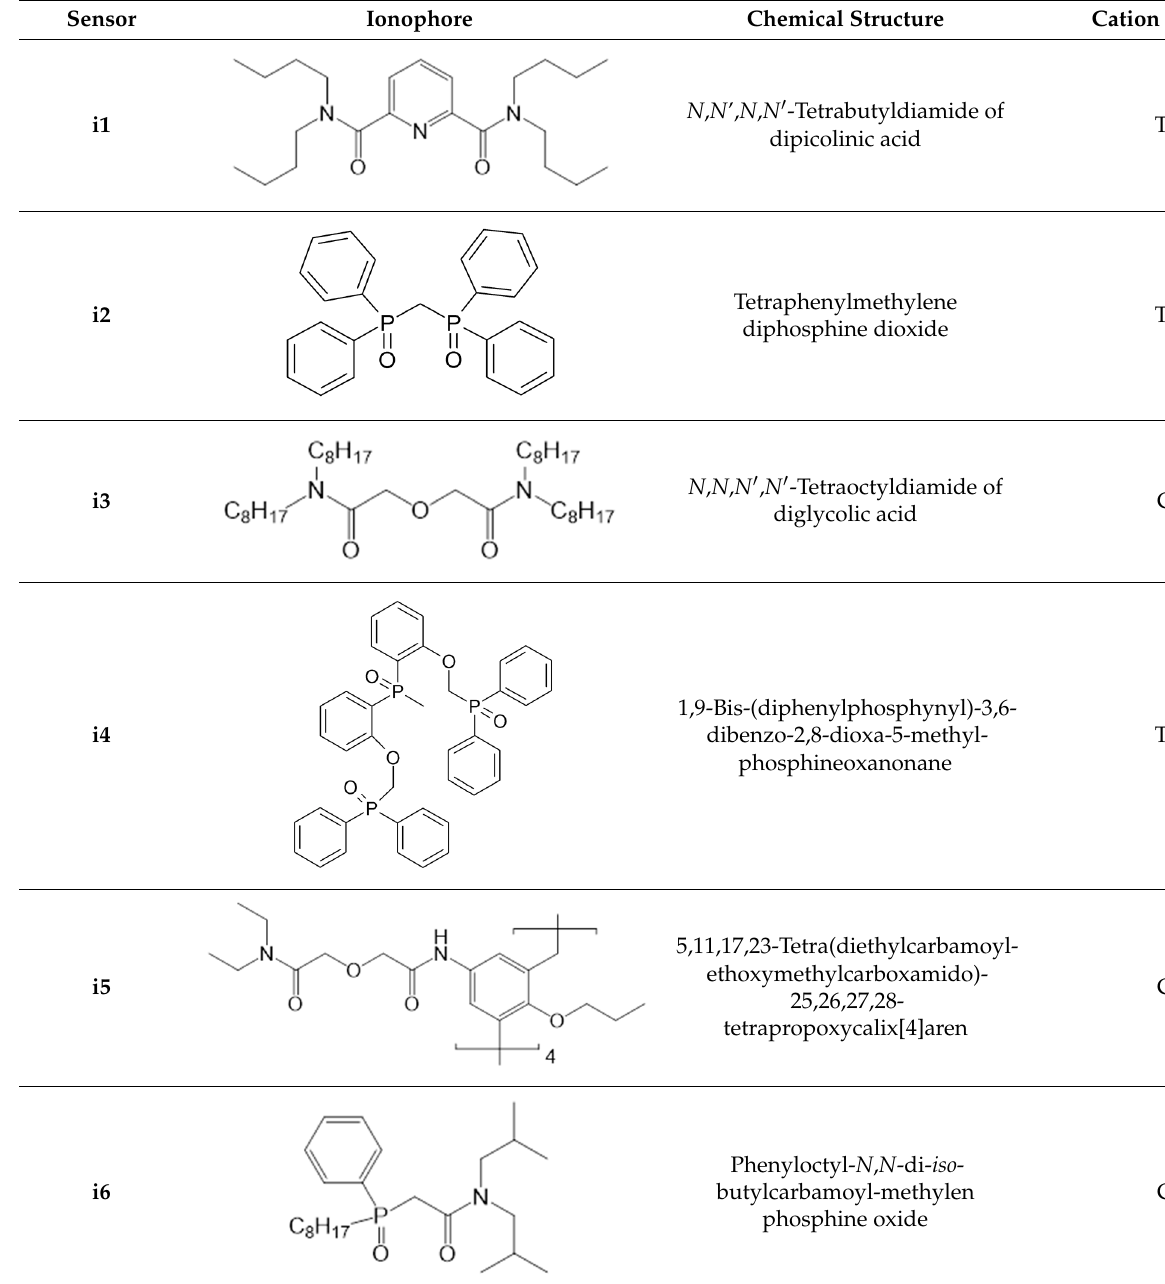
Table 1. Chemical structures of the employed ionophores.